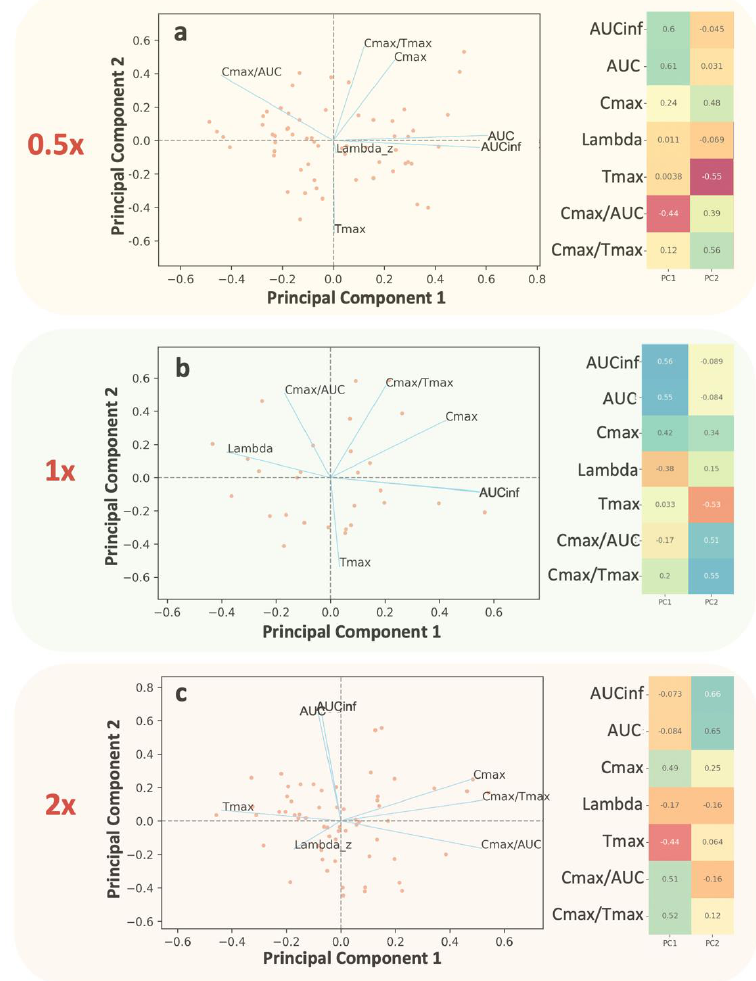
Figure 6. Principal component analysis of the three simulated bioequivalence studies. Depending on the assumed absorption rate constant (Ka), PCA was applied separately the following three cases: ( a ) Setting Ka equal to the half of the true Ka (i.e., 0.5x-), ( b ) equal to the true Ka (i.e., 1x-), ( c ) twice the value of the actual Ka (i.e., 2x-). The left panels refer to the biplot of the two principal components (PC), where the individual scores and the loadings (blue lines) of the pharmacokinetic parameters are shown. The right panels denote the “loadings” for the two first PCs.